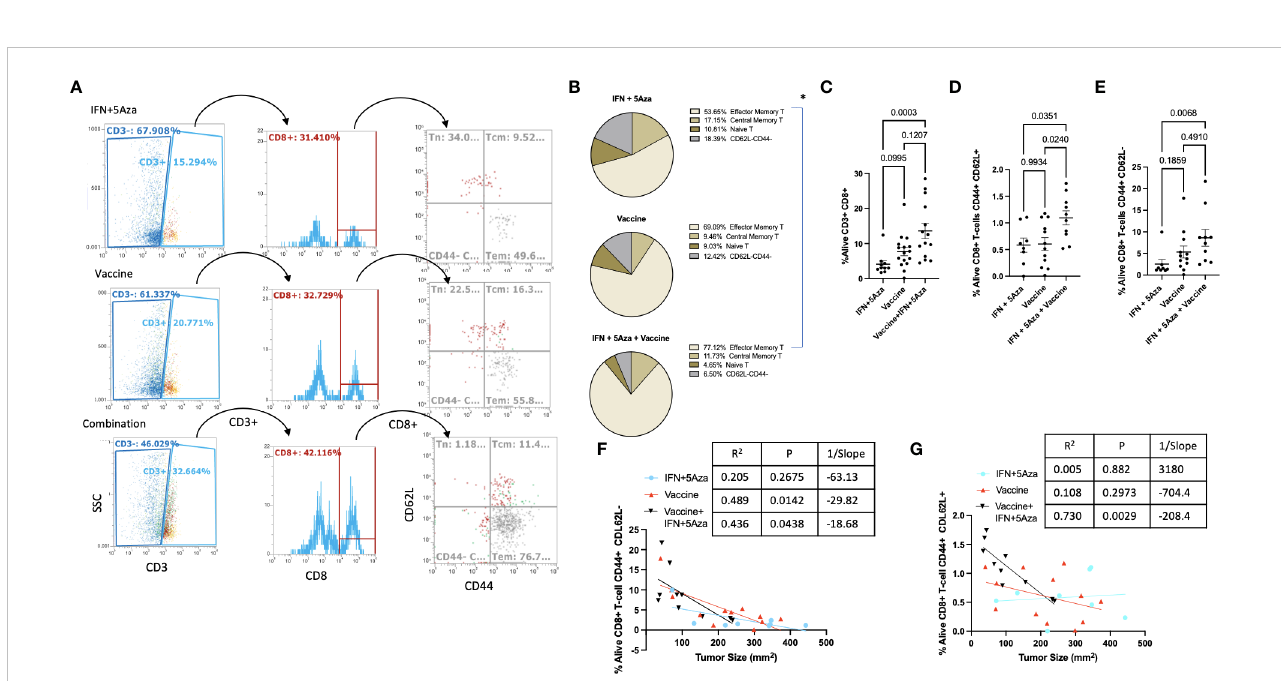
FIGURE 5 T-cell subtype analysis. (A) Gating structure. CD3+CD8+ cells are divided by CD44 and CD62L expression patterns. CD44+CD62L- are T effector/ effector memory cells, CD44+CD62L+ are central memory T-cells, and CD44-CD62L+ are naïve T-cells. Plots shown are representative samples from their groups. (B) For each group, proportions of the three primary subtypes are plotted by pie chart. (C – E) %Alive analysis of tumor in fi ltrating populations of (C) all CD8+ T-cells, (D) Central Memory CD8+ T-cells, and (E) effector/effector memory CD8+ T-cells. (F, G) Correlation analysis between (F) CD8+ Tem or (G) CD8+ Tcm and tumor size. Data are representative of 3-4 independent experiments with 10-16 total mice per group. Groups were tested by One-Way Anova with multiple comparisons: Tukey ’ s test (B – D) or Dunn ’ s test (E) . Correlations tested by Spearman correlation coef fi cient test.